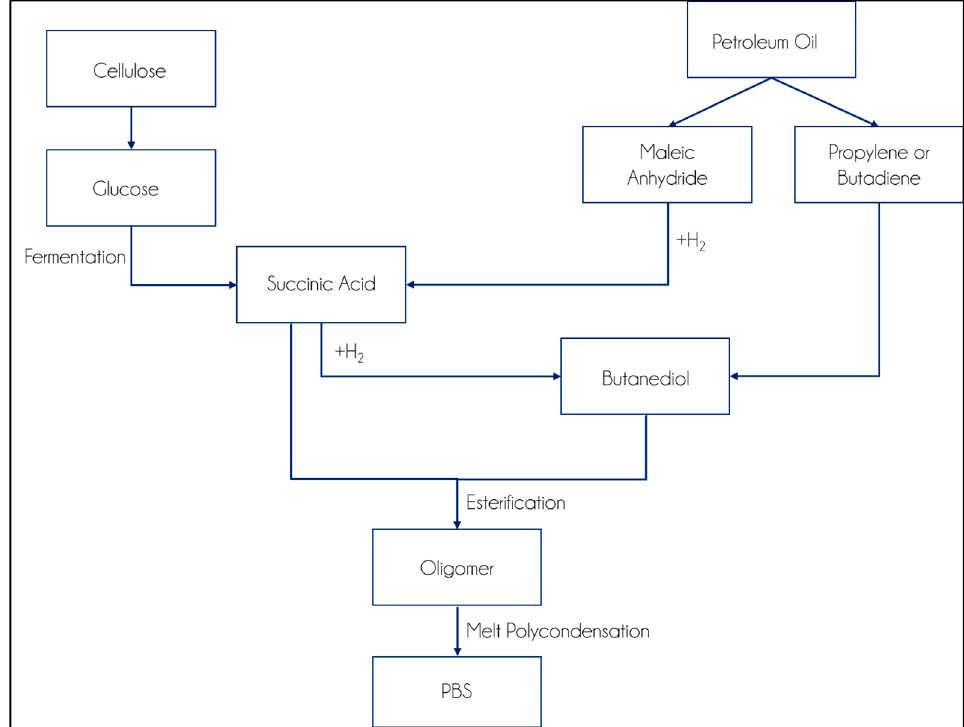
Figure 2. Flow Chart of PBS synthesis [Adapted with permission from Reference [43]. Copyright 2010 Wiley].